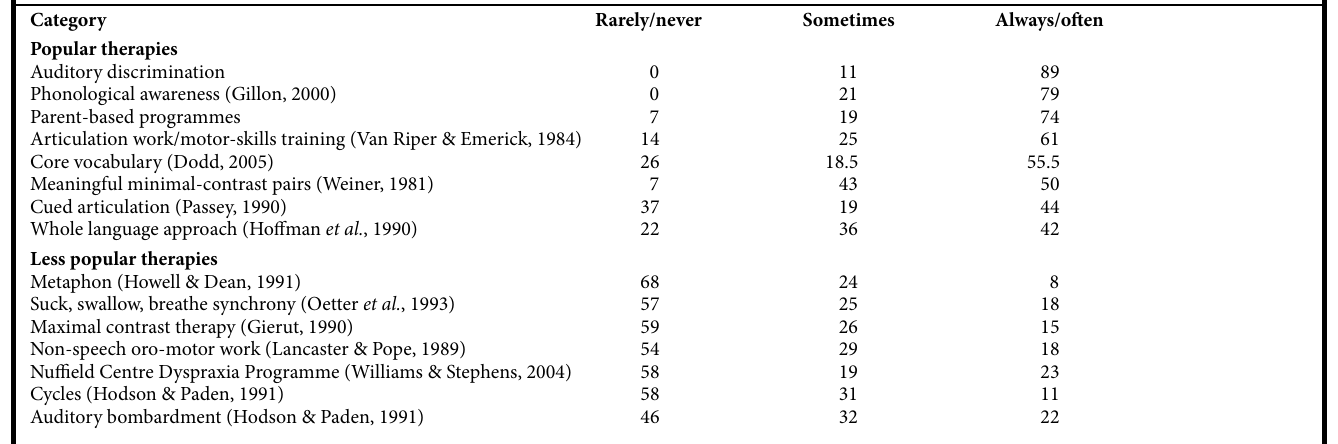
Table I. Percentage of participants ( n= 28) using individual therapies Category Rarely/never Sometimes Always/often Popular therapies Auditory